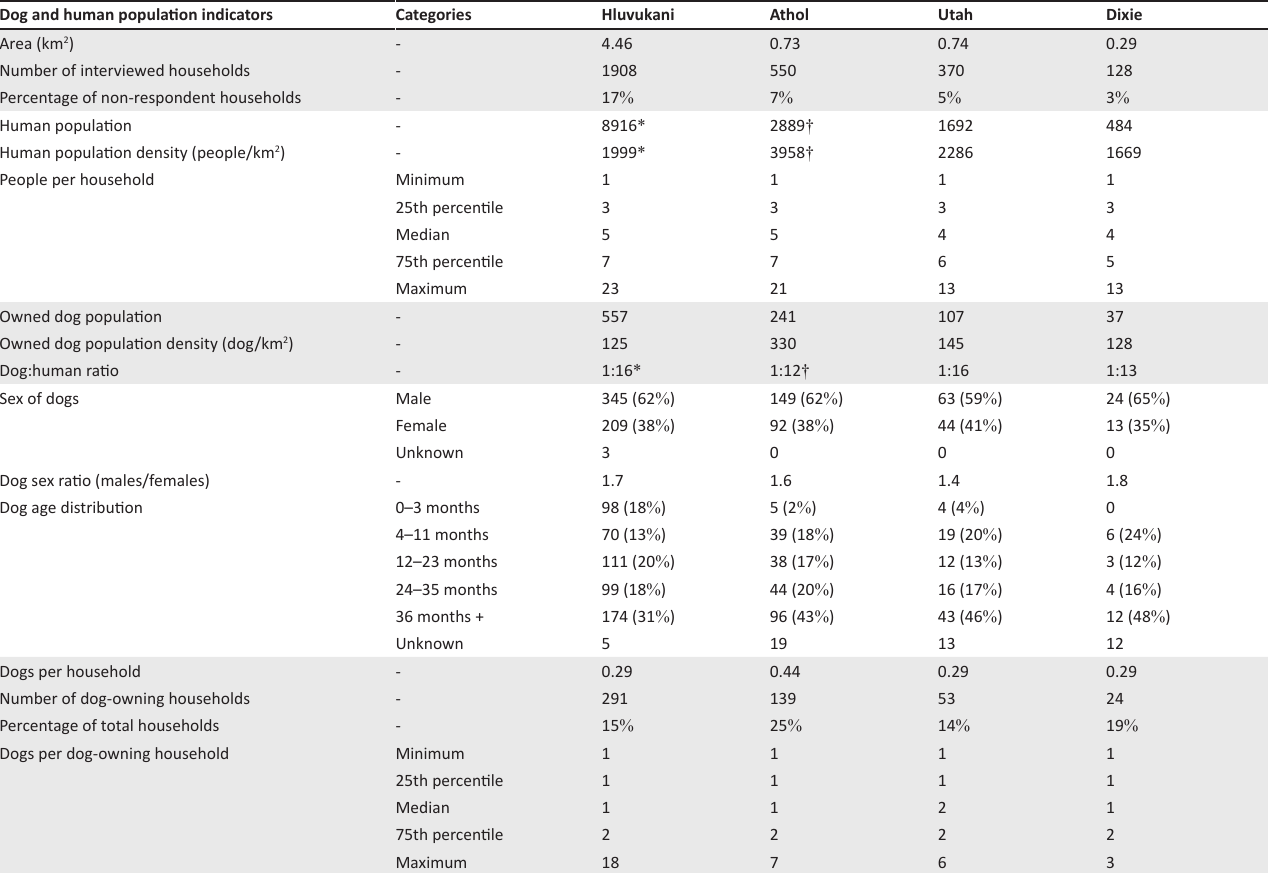
TABLE 1: Dog and human population description in four resource-limited rural villages at proximity of wildlife conservation areas, Mnisi Tribal Authority, Bushbuckridge Municipality, Mpumalanga province, South Africa (2013). Dog and human population indicators